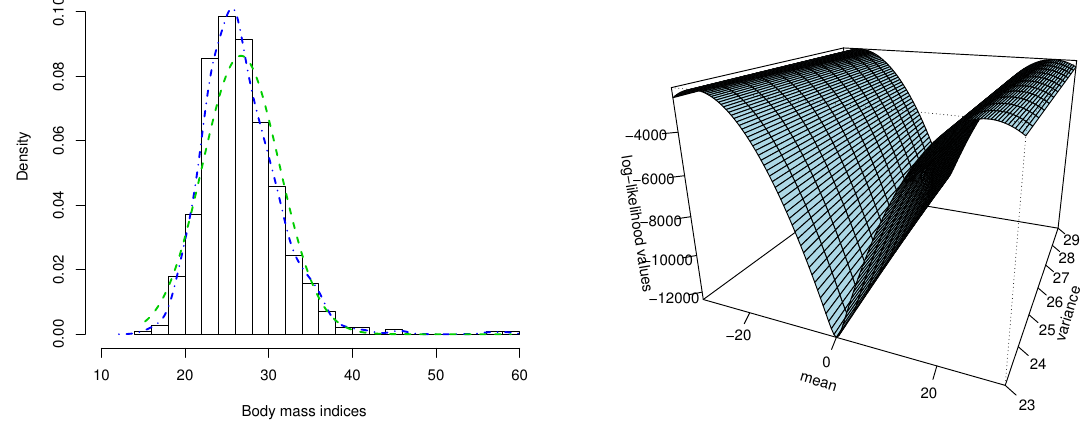
Figure 6. The histogram on the left shows the body mass indices of 700 New Zealand adults. The green line is the fitted folded normal and the blue line is the kernel density. The perspective plot on the right shows the log-likelihood of the body mass index data as a function of the mean and the